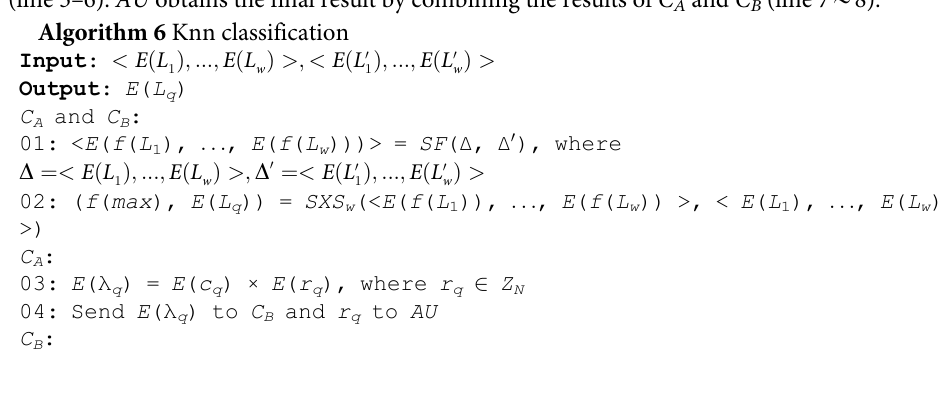
Algorithm 6 Knn